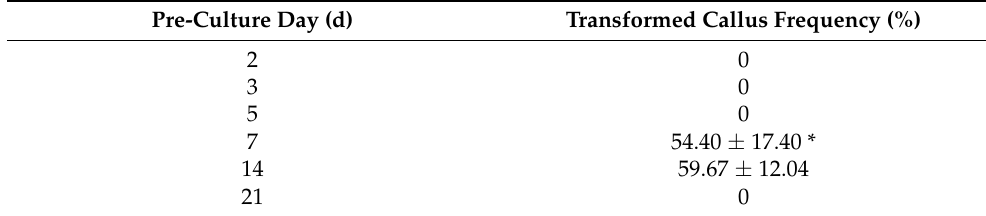
Table 2. Effects of pre-culture day on